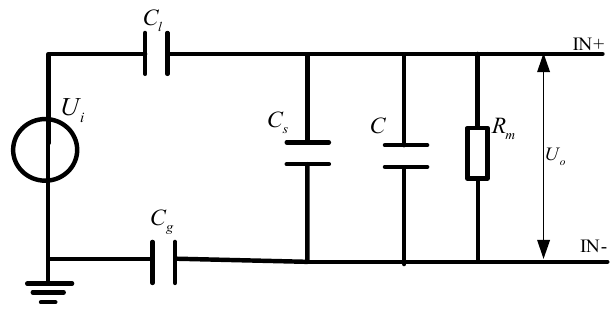
Figure 7. Sensor measurement equivalent circuit.